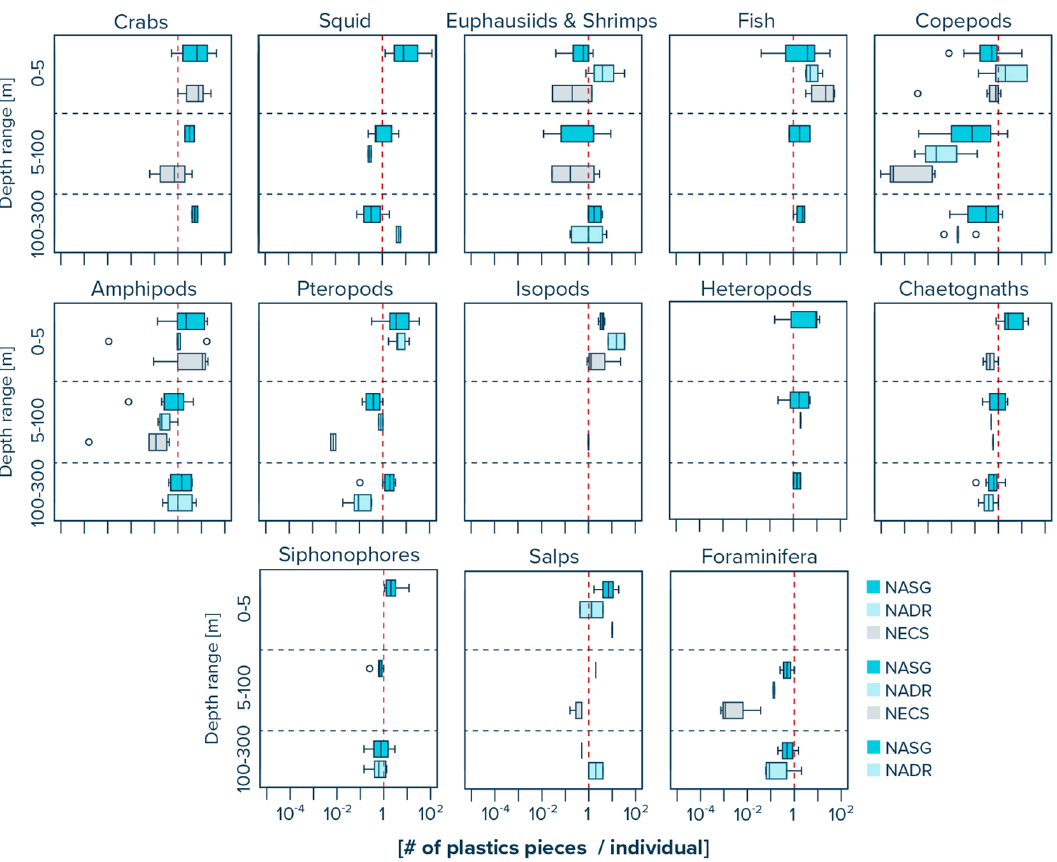
Figure 5. Observed water column distribution of plastic to organism ratios for three specific water layers (i.e., 0–5 m, 5–100 m and 100–300 m) in the North Atlantic Subtropical Gyre (NASG), the North Atlantic Drift Region (NADR), and the Northeast Atlantic Continental Shelves (NECS). Solid vertical lines represent median values. Box plots extend from the 25th to the 75th percentiles, while whiskers extend from the minimum to the maximum observed values. Dots indicate outliers. Red dashed vertical line represents x-axis value of 1 for better visual comparison between the taxa. Note that all values are provided in Supplementary Table